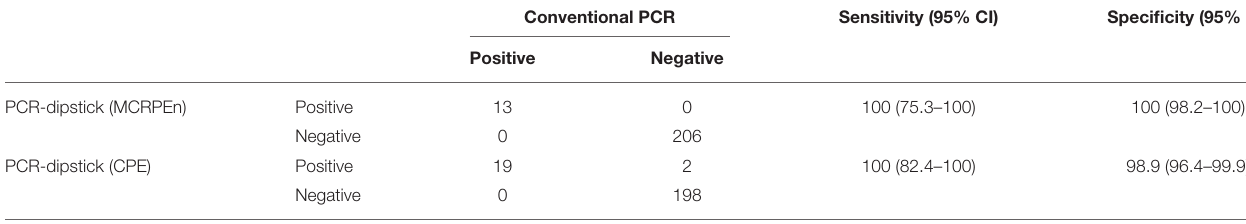
TABLE 3 | Sensitivity and specificity of PCR-dipstick vs. conventional PCR for 219 rectal swab specimens.